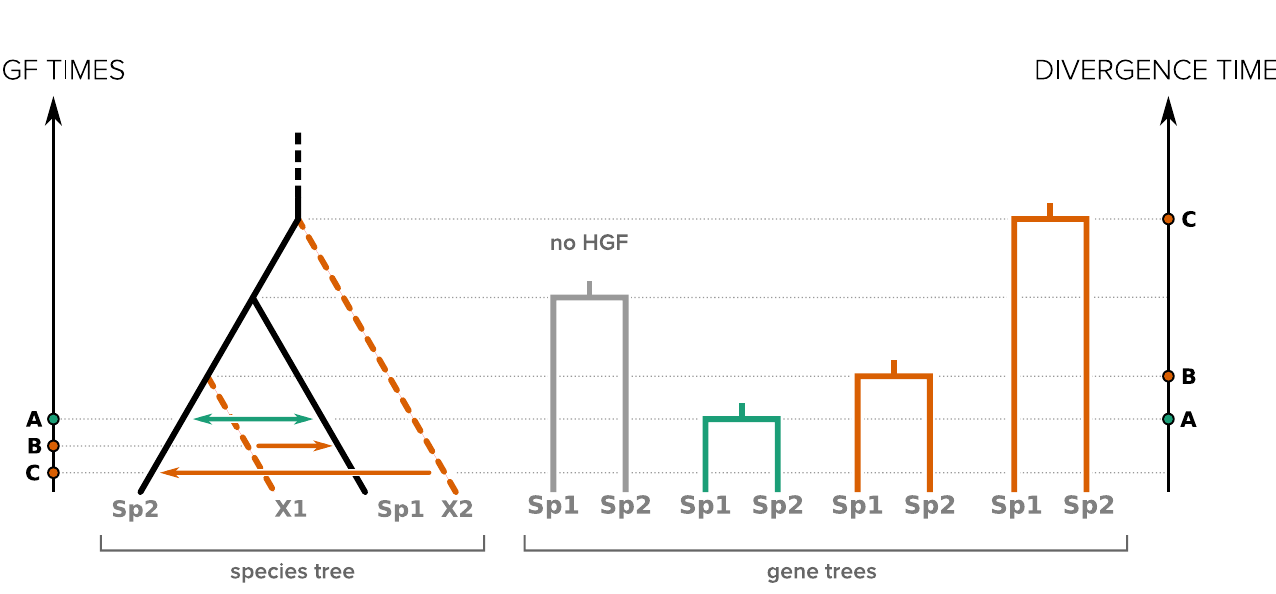
Fig 1. Effect of HGF on branch lengths in phylogenetic trees of the horizontally transferred genomic regions. Only the recipient species and its closest relative are represented in each gene tree. Green arrows depict HGF between lineages used in the analysis, while orange arrows represent HGF involving ghosts. A, B, and C represent the 3 HGF considered.